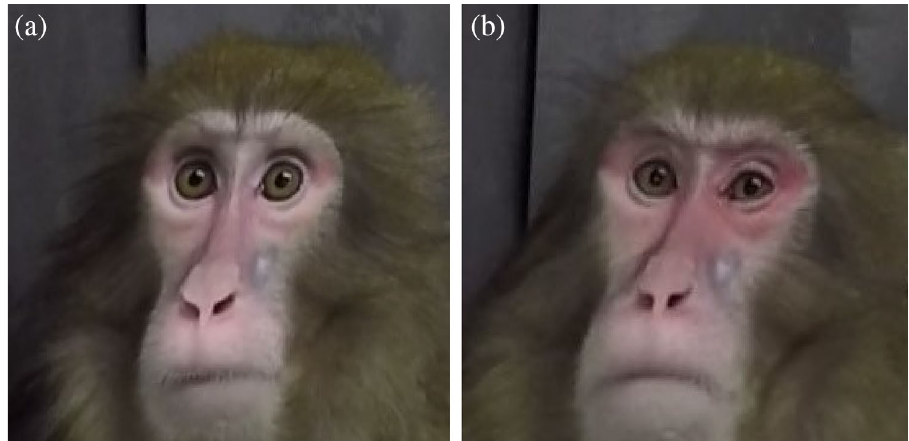
Figure 2. An example of eyelid asymmetry in a female Japanese macaque before and after laparotomy. ( a ) Pre: the subject is alert, presenting relatively symmetrical facial features. ( b ) D1: the picture was taken before scheduled analgesia. The left eye is more closed than the right